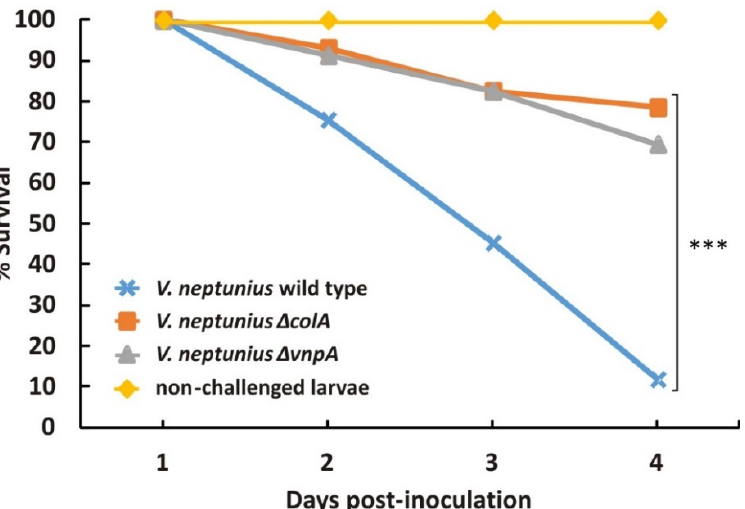
Figure 3. Survival curves after challenge in oyster larvae ( Ostrea edulis ) with the wild-type V. nep- tunius strain or Δ colA - or Δ vnpA -defective mutants. Asterisks denote statistically significant dif- strain or ∆ colA - or ∆ vnpA -defective mutants. Asterisks denote statistically significant differences ferences between strains (*** p < 0.001). between strains (*** p <